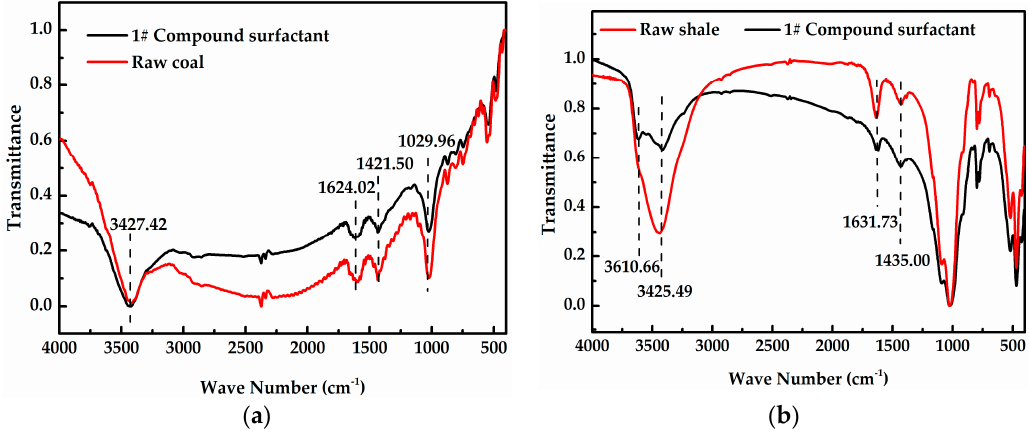
Figure 7. FT-IR spectrum of the Longtan coal ( a ) and the longmaxi shale ( b ) samples before an after treatment with compound surfactants.